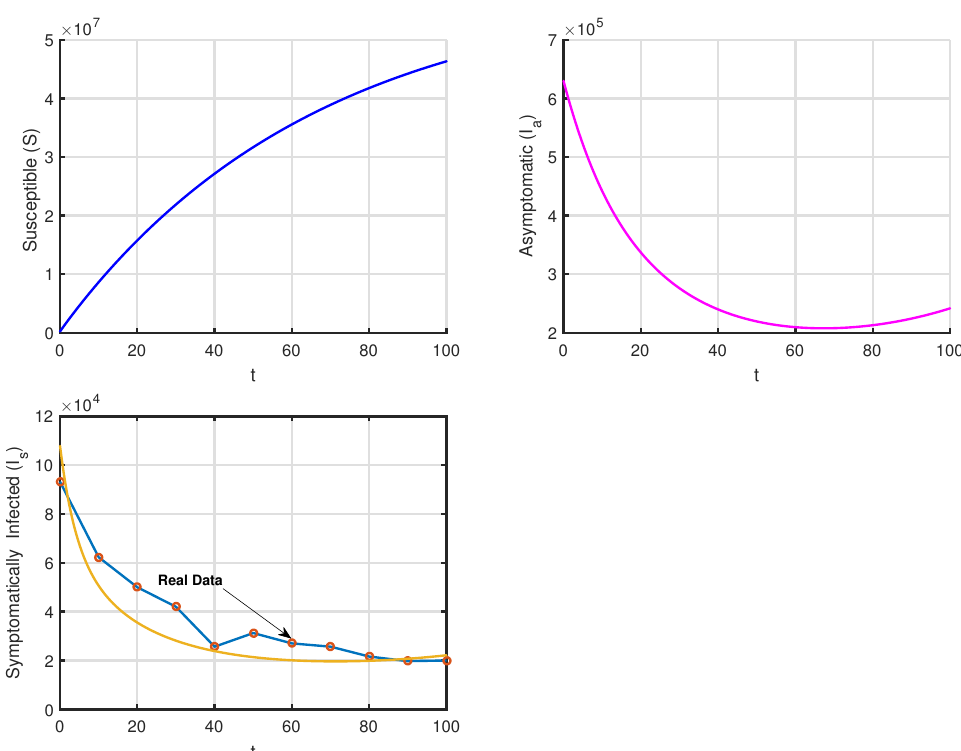
Figure 3. Time series of S , I a , I s for 100 days from 1 January 2022 to 10 June 2022 when controls (both government measures and public behaviour) are applied.